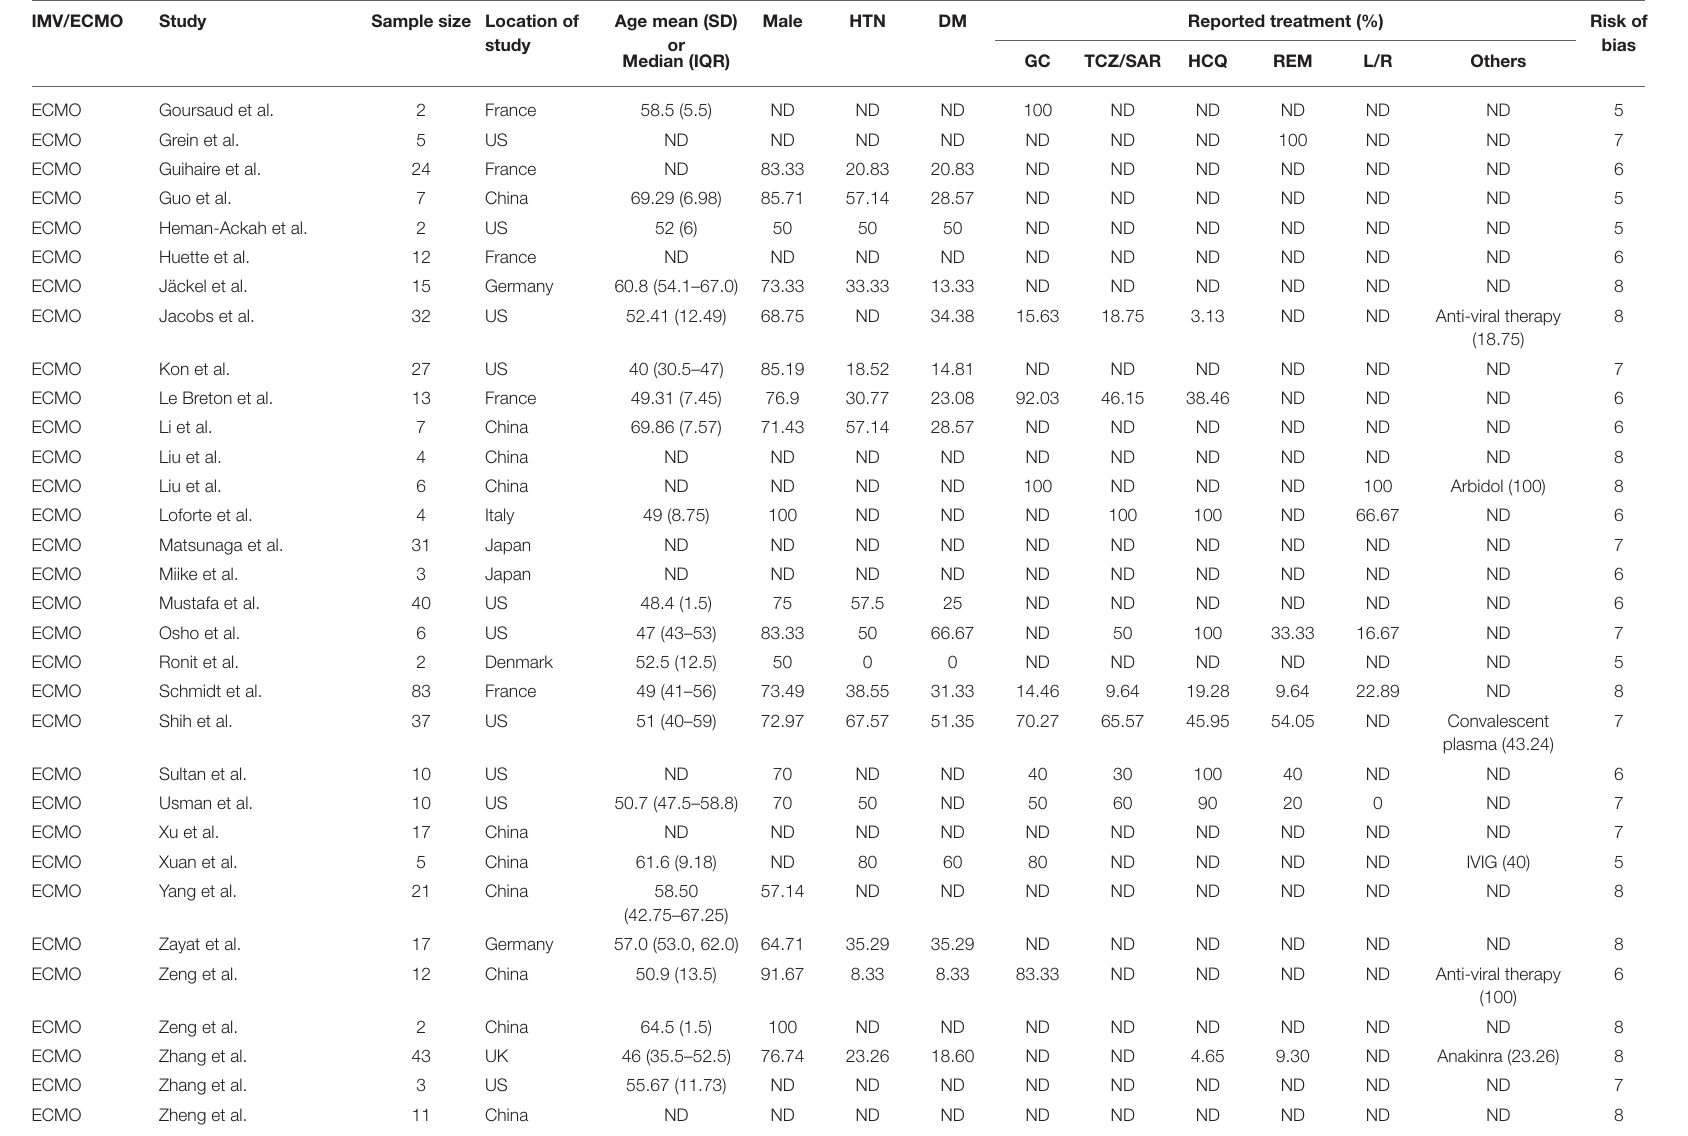
ECMO ECMO Zayat et al. ECMO Zeng et al. ECMO Zeng et al. ECMO Zhang et al. ECMO Zhang et al. ECMO Zheng et